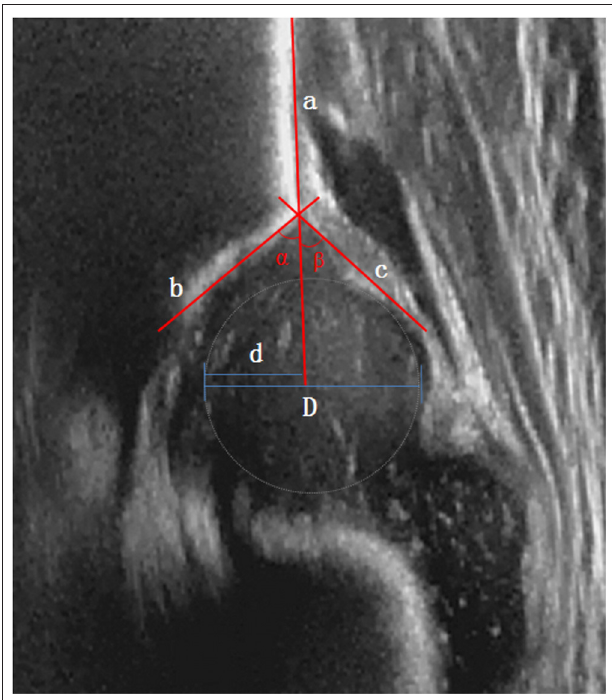
FIGURE 1 | Measurements of α angle, β angle, and femoral head coverage by Graf methods. of |r| ≥ 0.8 indicate strong correlation; 0.5 ≤ | r | < 0.8 indicate moderate correlation; 0.3 ≤ | r | < 0.5 indicate weak correlation; and | r | < 0.3 indicate no correlation. Differences with p < 0.05 were considered statistically significant.